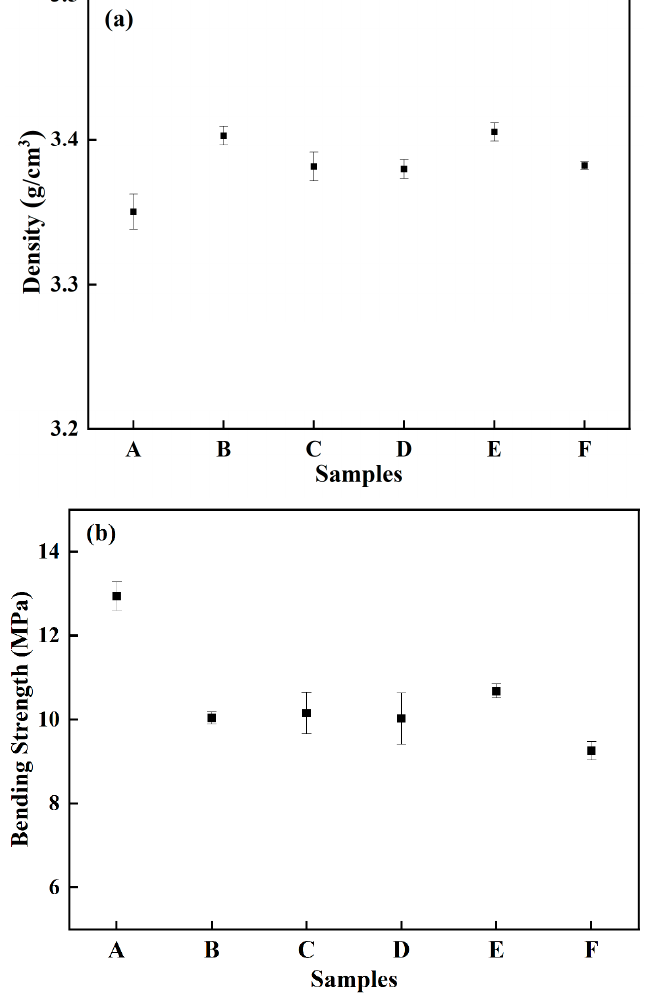
Figure 4. Densities ( a ) and bending strengths ( b ) of green parts with different coupling media.